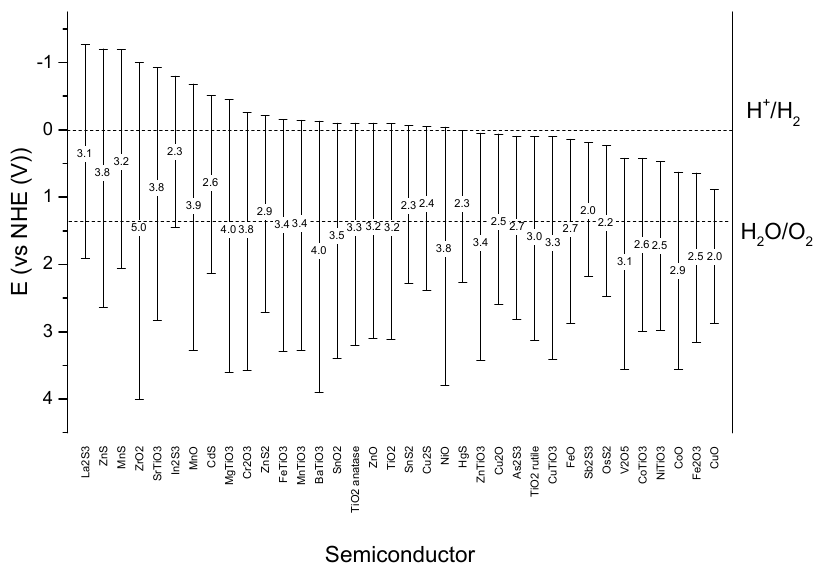
Figure 4. Relative position of the edges of the conduction and valence bands of some semiconductors. Adapted from References [78,79].